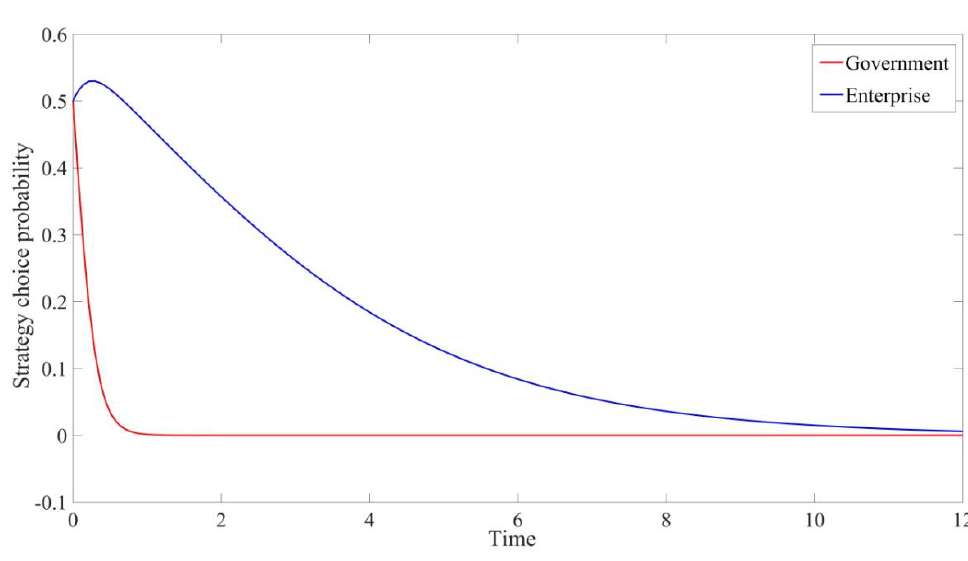
Figure 6. Simulation results of the partial equilibrium point (0,0).